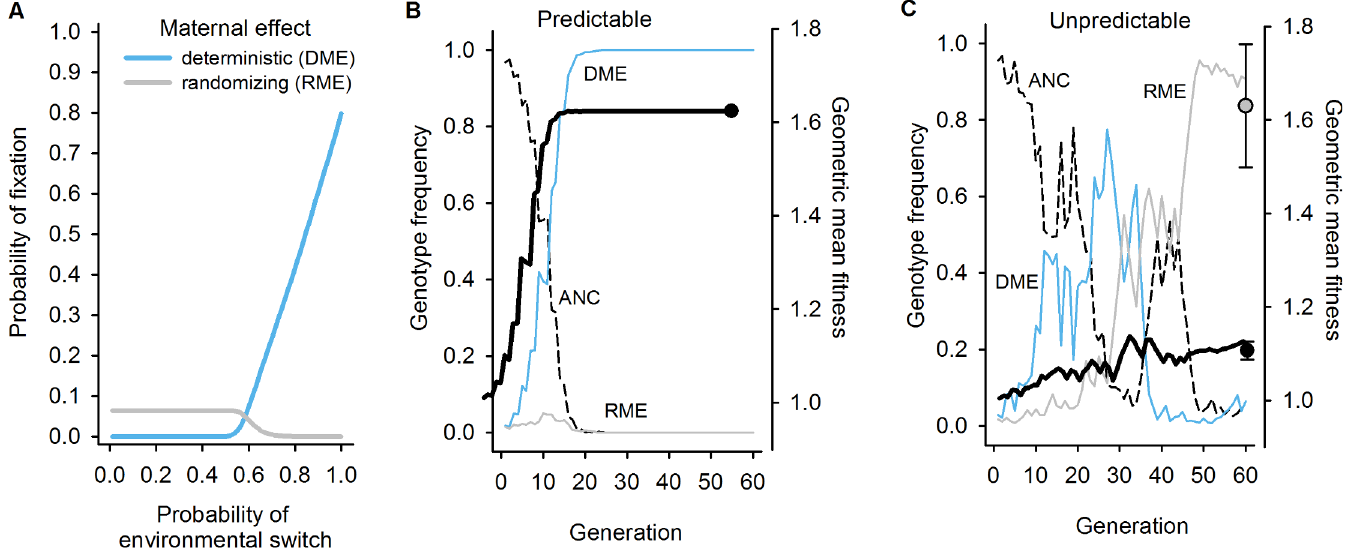
Fig 7. Expected population genetics of maternal effects during experimental evolution. (A) The probability of fixation of an allele expressing a deterministic maternal effect (blue line) or randomizing maternal effect (grey line), when invading the ancestral population exclusively composed of an allele not expressing maternal effects. Results are from 10,000 randomly drawn fitness parameters with γ = 2.0, thus producing approximately 2-fold fitness effects on average (see Materials and Methods). Other distributions of fitness effects yield qualitatively similar results. Fixation probabilities were calculated assuming an effective population size of 10 3 , one order of magnitude lower than experimental census sizes [53,69], and an initial frequency of 0.01, using M. Kimura ’ s approximation of the Wright-Fisher sampling process (see Materials and Methods) [68,70,71]. (B, C) Illustrative numerical simulations mimicking the evolution of maternal effects during experimental evolution (see Materials and Methods). (B) The probability of environmental transition was set to 0.95, as the predictable populations experienced during experimental evolution. Relative fitness values are of W A-to-N = 0.335 and W A-to-A = 2.63. These values are, thus, similar to those measured after experimental evolution (Fig 2C). The deterministic maternal effect allele (DME; blue line) reaches fixation at generation 24, during which the population geometric mean fitness (black line) increased to the expected value of the square root of 2.63. Fifty simulations with the same parameter values show that by generation 60 there is always fixation of the DME allele and, thus, the same geometric mean fitness among populations (black circle). The randomizing maternal effect allele (RME; grey line) does not invade the ancestral population (dashed line). (C) As in panel (B), W A-to-N = 0.335 and W A-to-A = 2.63, but the probability of environmental transition was 0.55, as the unpredictable populations experienced during experimental evolution. After 60 generations, the frequency of the RME allele reaches 0.91. Fifty simulations with the same parameter values show that the RME generally approaches fixation by generation 60 (grey circle; mean and one standard deviation) and, thus, that some variation is maintained in geometric mean fitness (black circle; mean and one standard deviation). Simulation code deposited in the Dryad repository: http://dx.doi.org/10.5061/dryad.56bb4